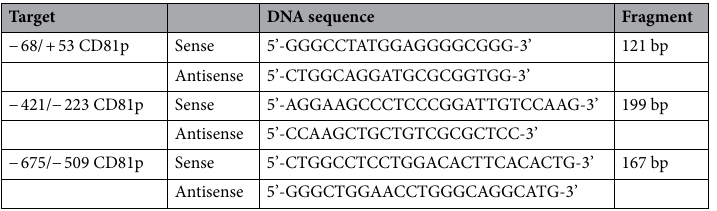
Table 1. DNA sequence of PCR primer for ChIP